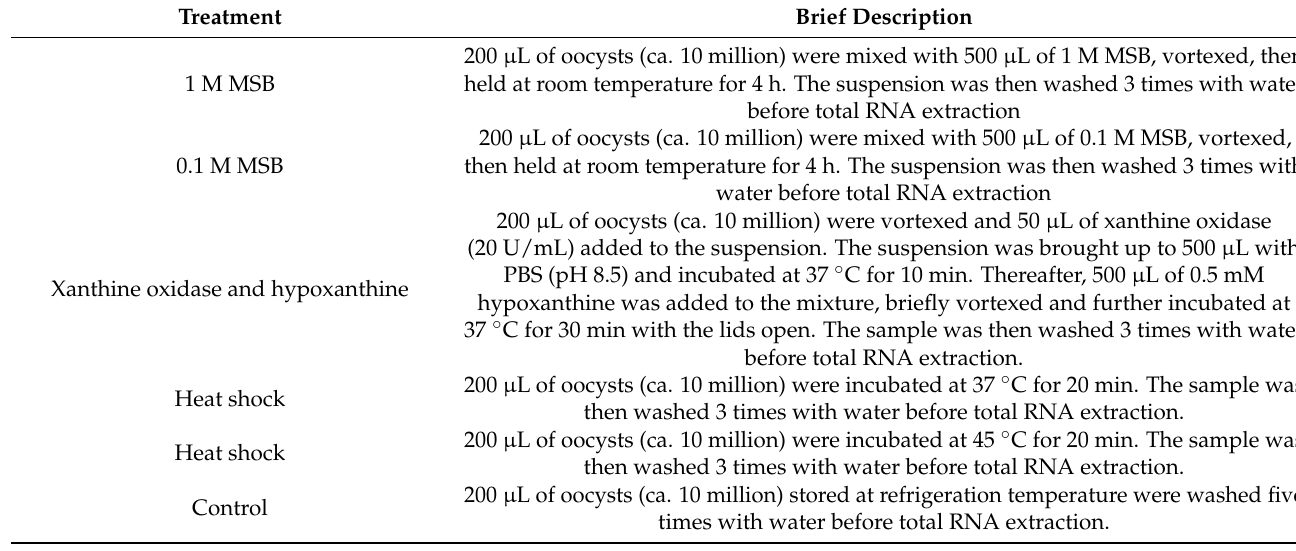
Table 1. Description of the gene expression induction approaches explored for RNA-Seq analysis. Treatment